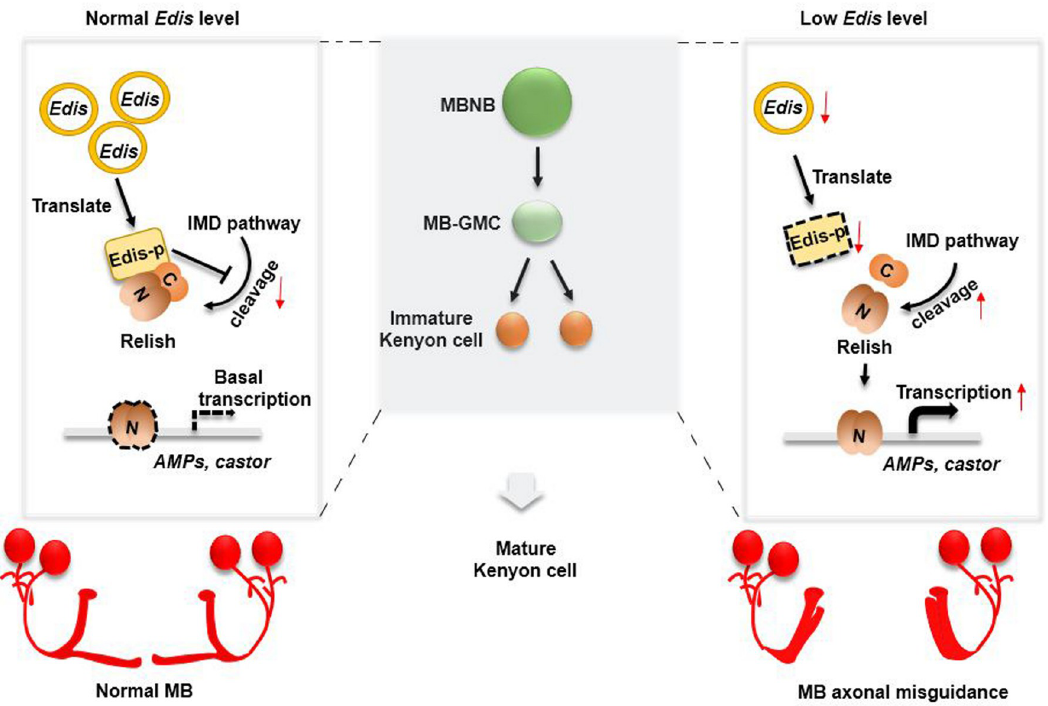
Fig 7. A diagram depicting the role of Edis in regulating neurodevelopment. With normal levels of Edis expression in Drosophila MB neuron precursors, Edis is translated into the Edis-p protein, which interacts with the immune transcription factor Relish and inhibits endoproteolytic processing/activation of Relish. Upon Edis depletion, Relish cleavage/activation is enhanced, which in turn promotes the transcription of both the AMP genes and castor , leading to MB neurodevelopmental